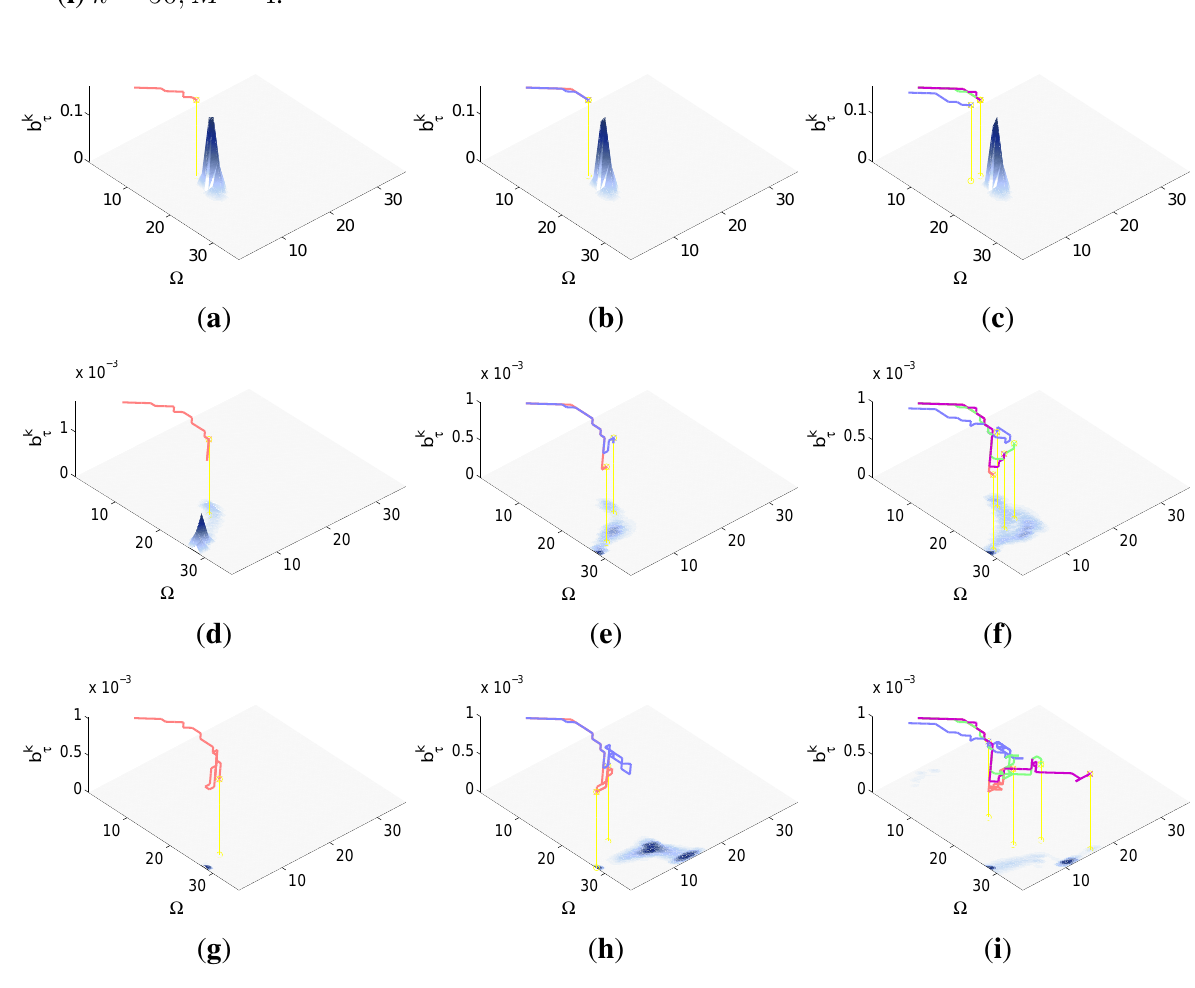
Figure 9. Simulations with the complex sensor in the dynamic radar